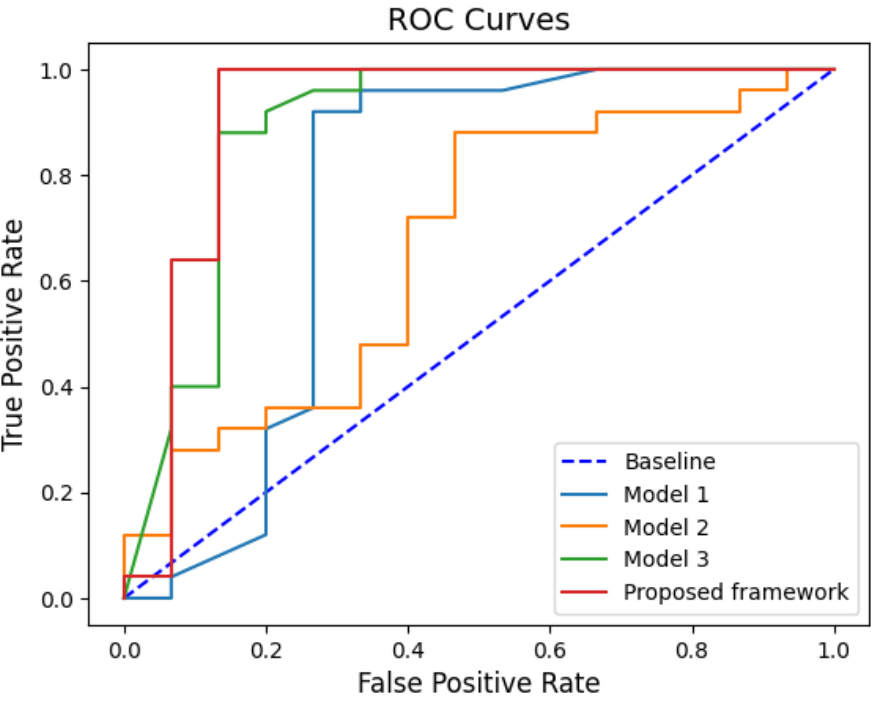
Figure 18. ROC curves and AUC values of the classification models.